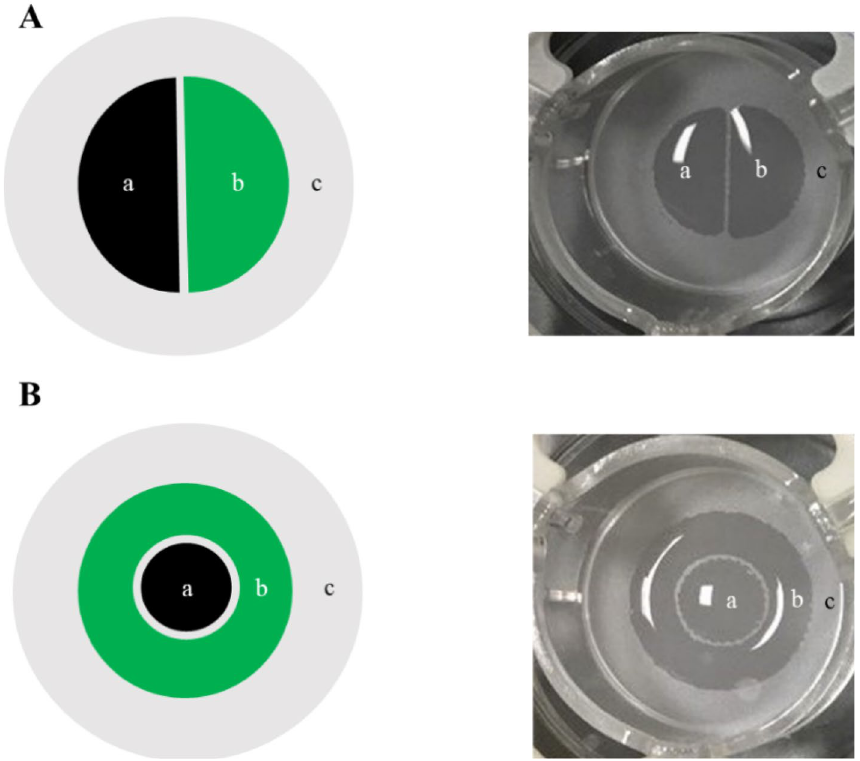
Figure 2. Macroscopic visualization of the cellular deposition design. Cells were printed in patterned cellular suspension in either semi-circles ( A ) or concentric rings ( B ) schematically illustrated as 2 separate NHK populations (left) or after seeding on a polycarbonate membrane after the bioprinting process (right). Pattern designs were drawn internally using BioCaD software